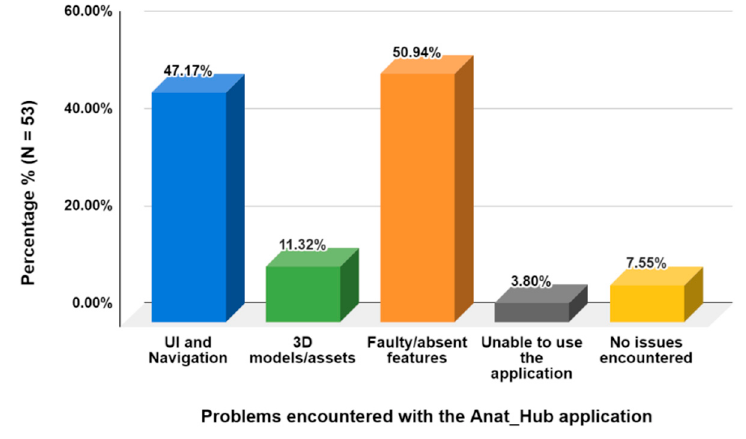
Figure 16. Problems encountered when using the Anat_Hub mobile application.